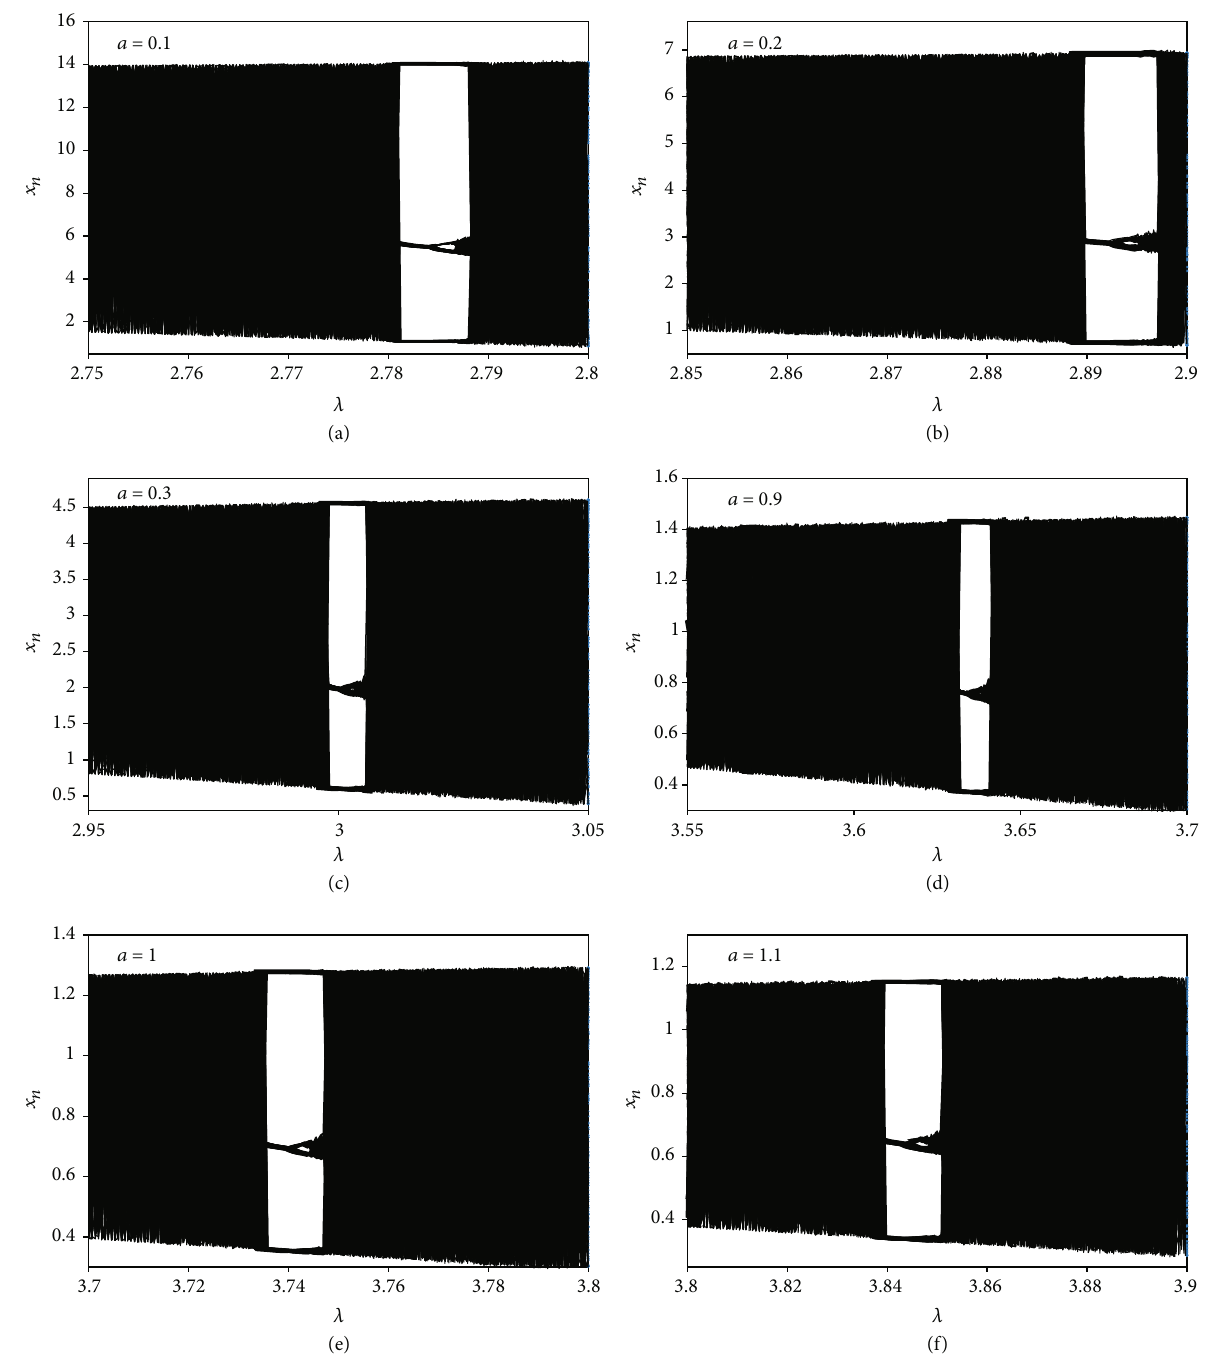
Figure 3: Bifurcation diagrams for period-3